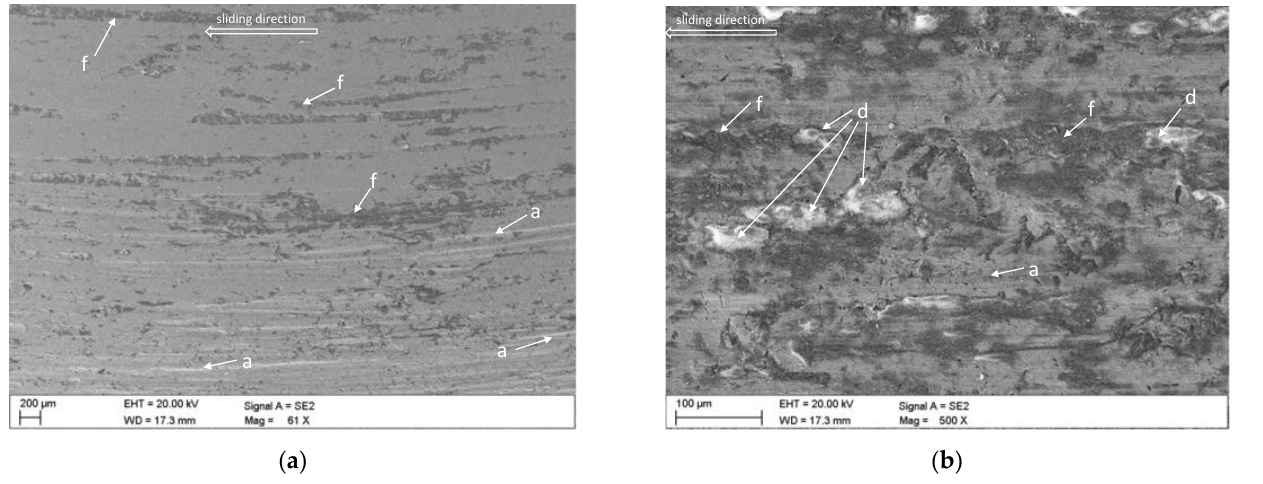
Figure 10. Views of WRS_400 steel surface (SEM) after tests with a mixture of 25% coal and 75% quartz sand (Variant II), cuttings filled with a coal-quartz mixture ( a ), crushed quartz grains in cavities filled with hard coal ( b ); symbols: a—grooves, d—debris, f—coal-filled surface damage.